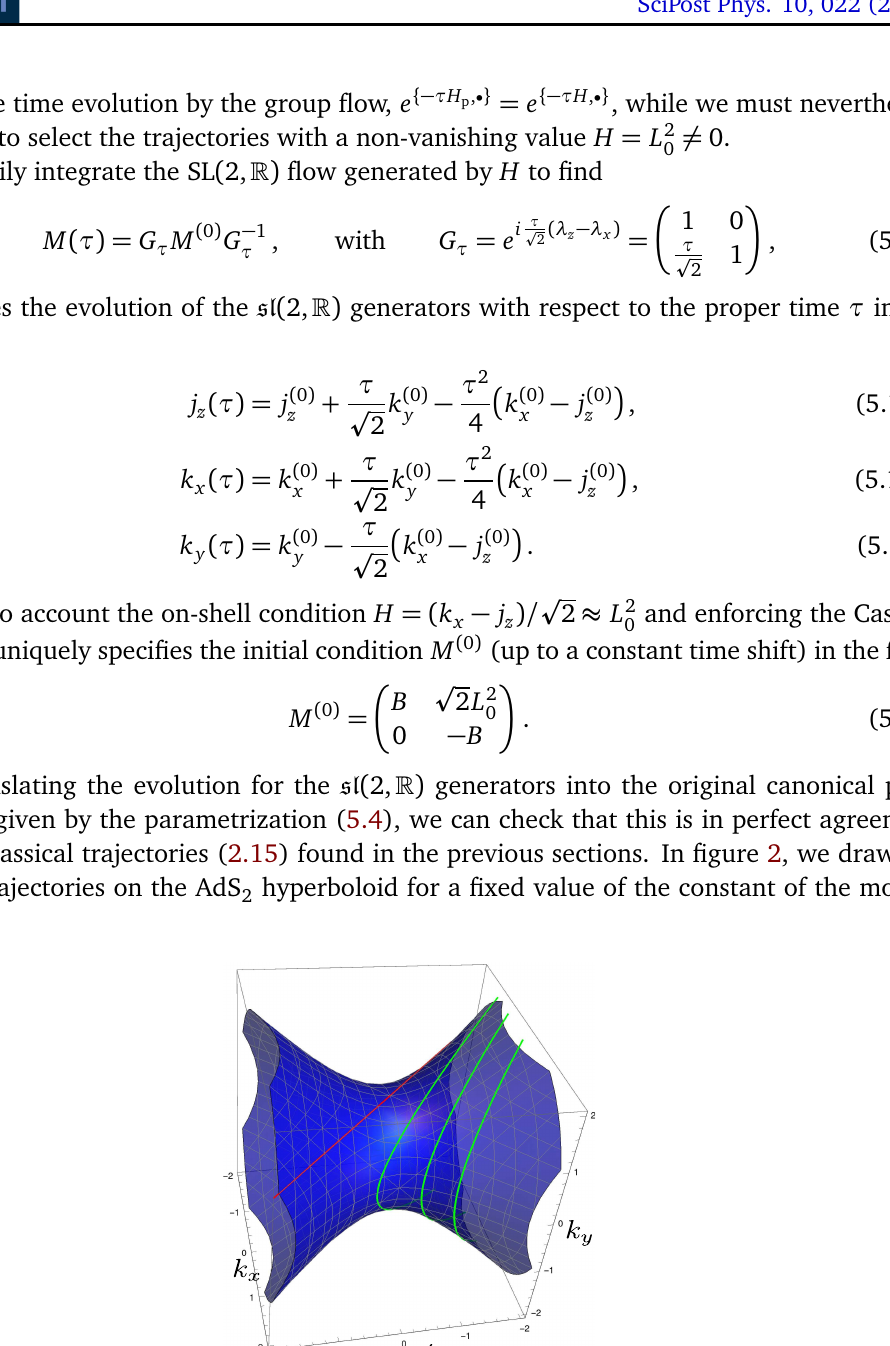
, these are horocycles on 0 = 0.5, 1, 1.5. Only the 0